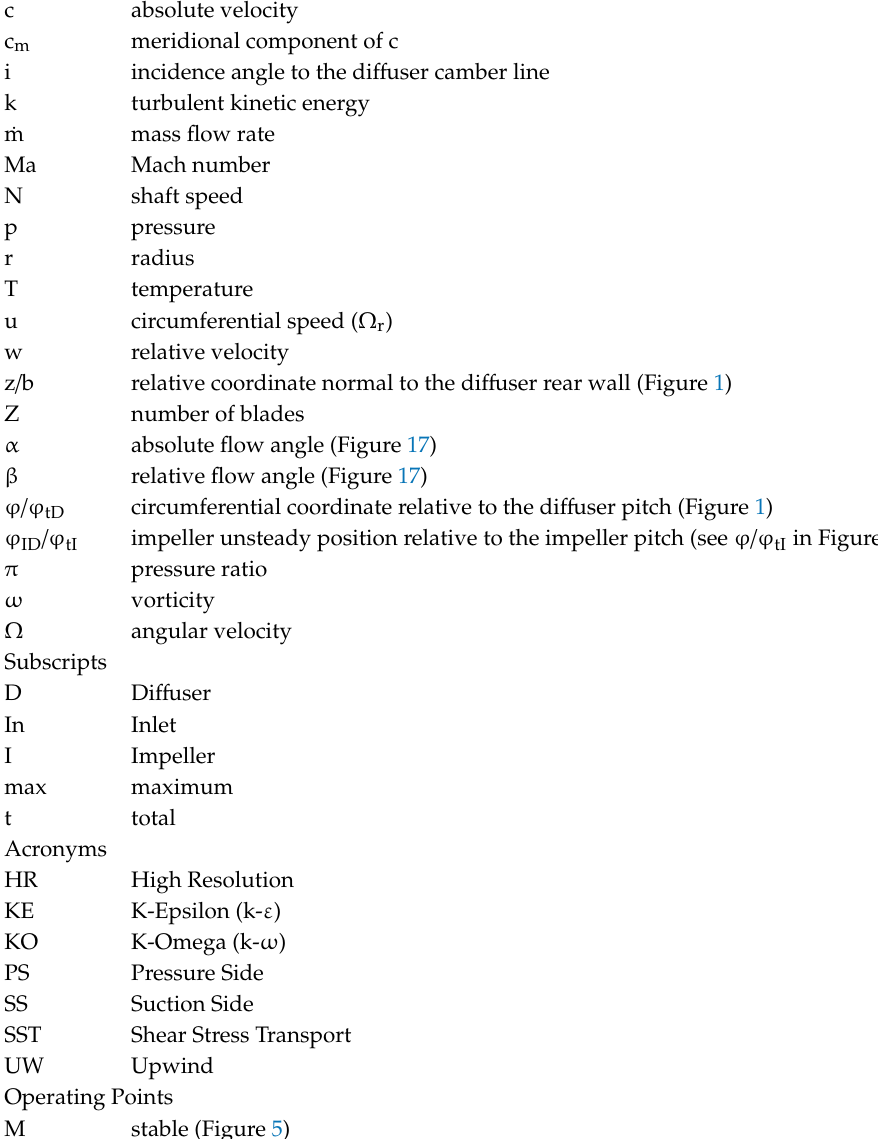
circumferential coordinate relative to the di ff user pitch (Figure